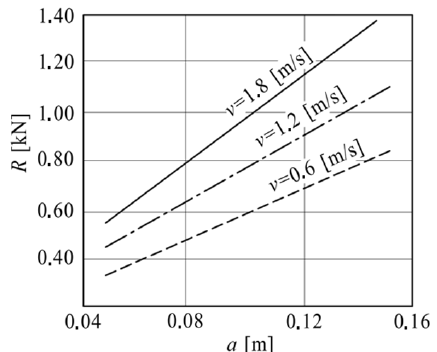
Figure 5. The dependence of the tractive resistance of the anchor colter on the tilling depth and the motion speed